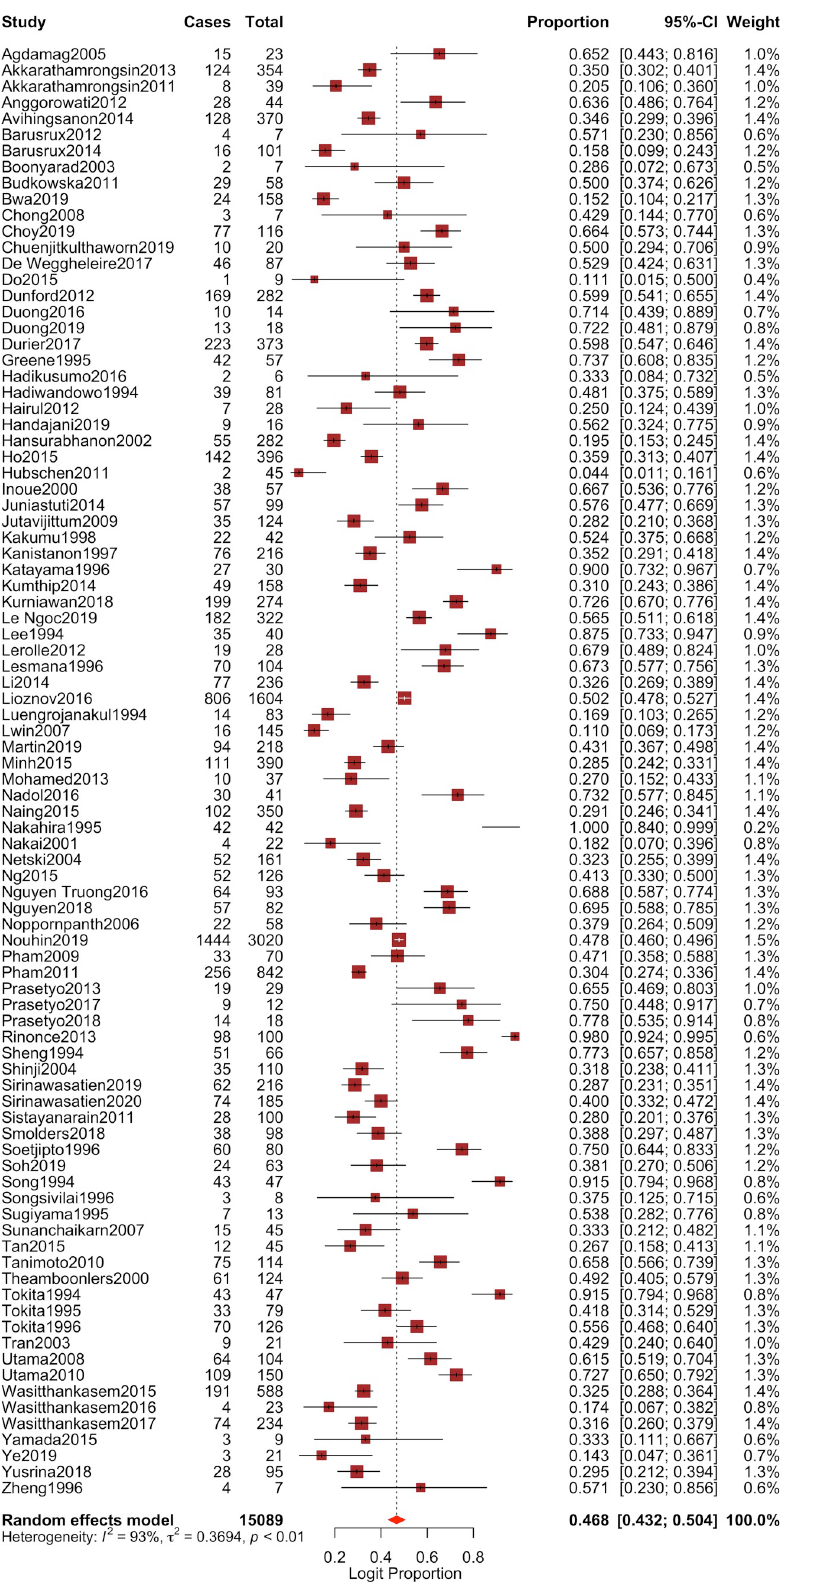
Fig 2. Forest plot showing pooled prevalence of HCV genotype 1 in Southeast Asia. https://doi.org/10.1371/journal.pone.0251673.g002 PLOS ONE | https://doi.org/10.1371/journal.pone.0251673 May 20,